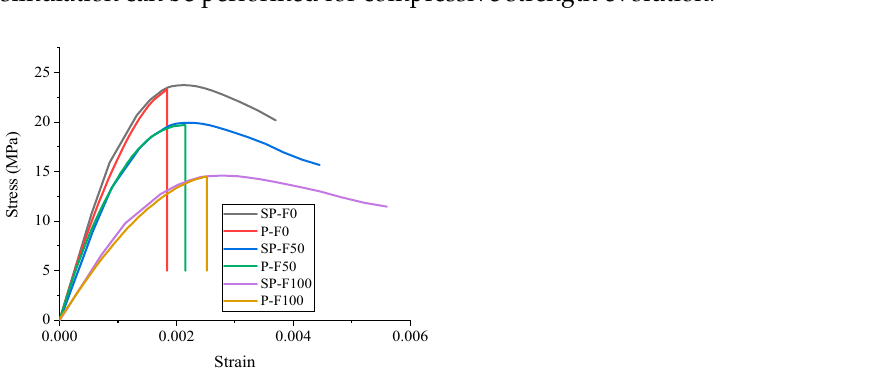
Figure 16. Stress in prismatic model at 99–100 freeze–thaws. ( a ) Stress of concrete; ( b ) stress of fiber cloth.